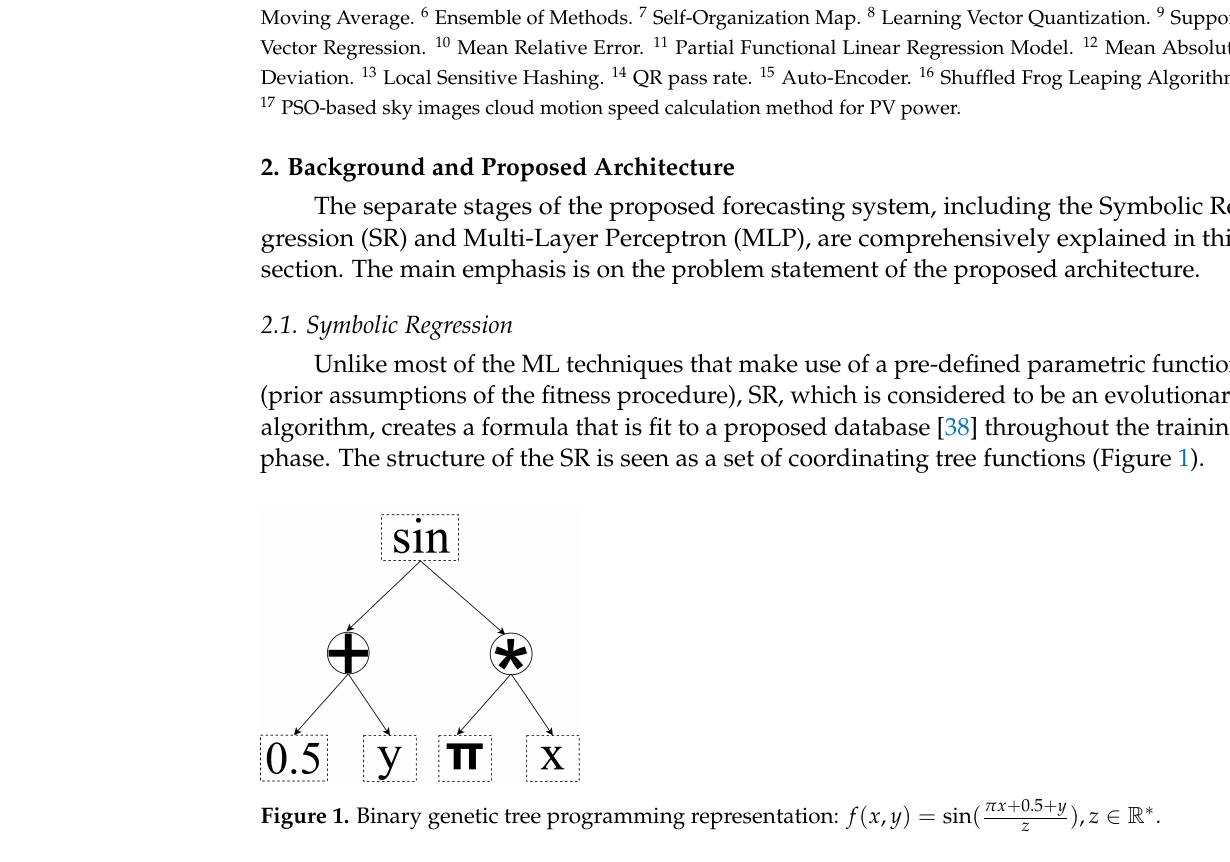
Figure 1. Binary genetic tree programming representation: f ( x , y ) = sin ( π x + 0.5 + y